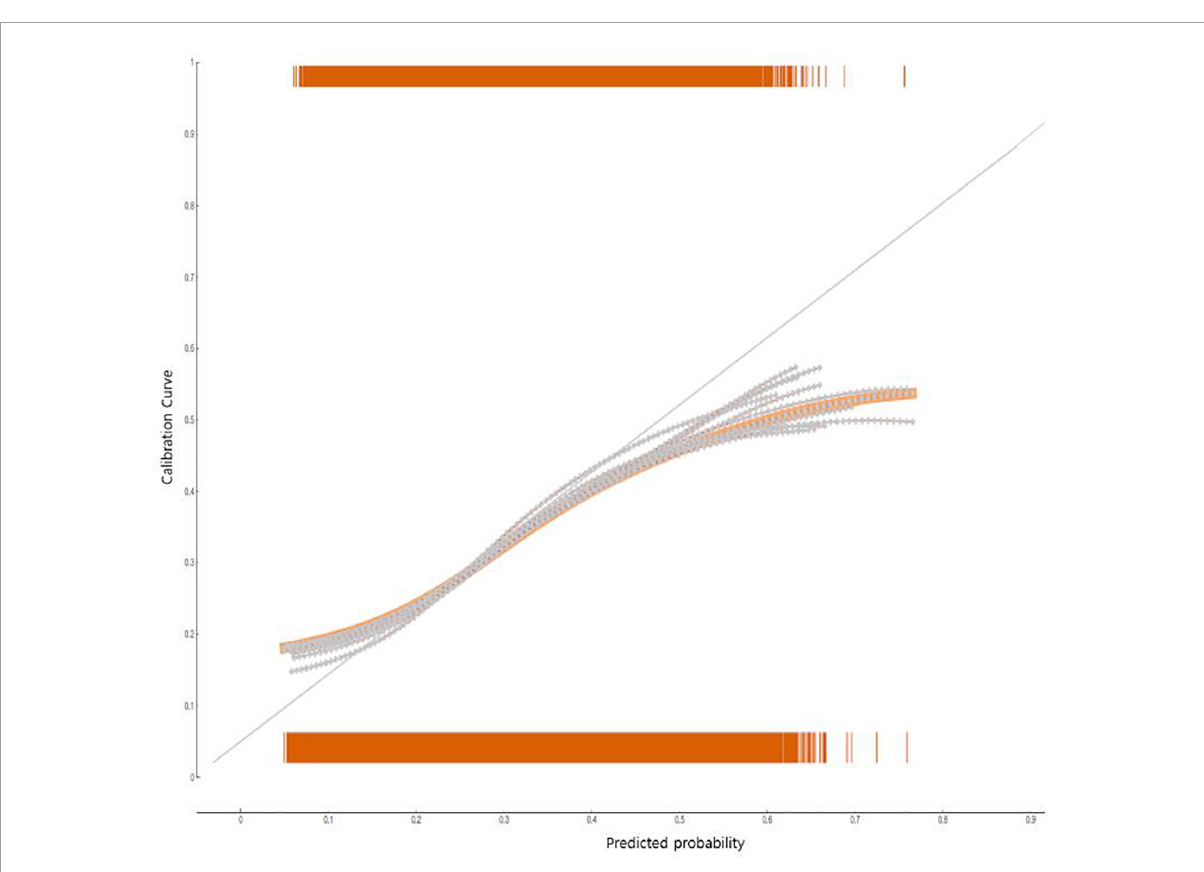
FIGURE3 The performance of the nomogram to predict groups vulnerable to obesity in South Korean adolescents: calibration plot.